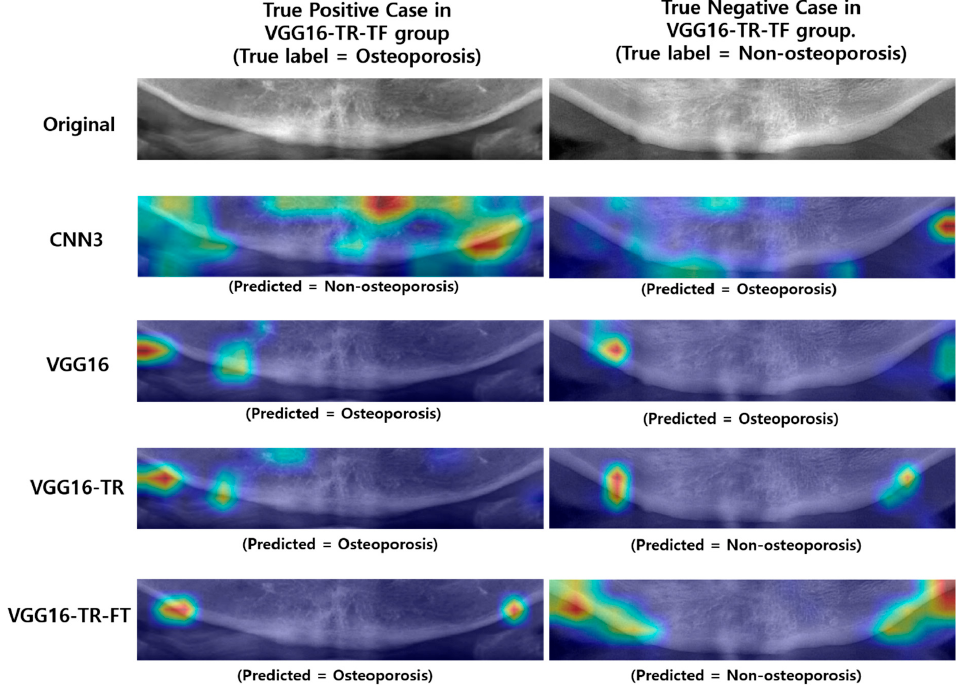
Figure 7. Comparison of grad-CAM images from other groups against some original images showing true positive and true negative in the best performing VGG16-TR-TF group.